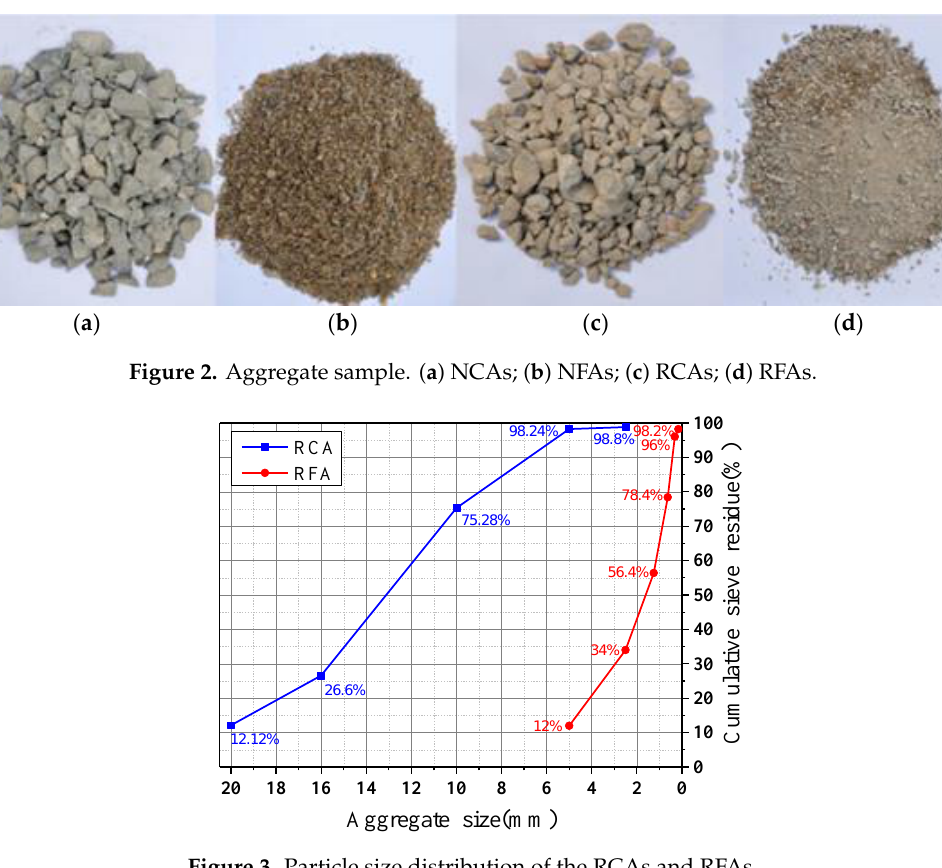
Figure 3. Particle size distribution of the RCAs and RFAs. Table 2. Basic properties of the aggregates